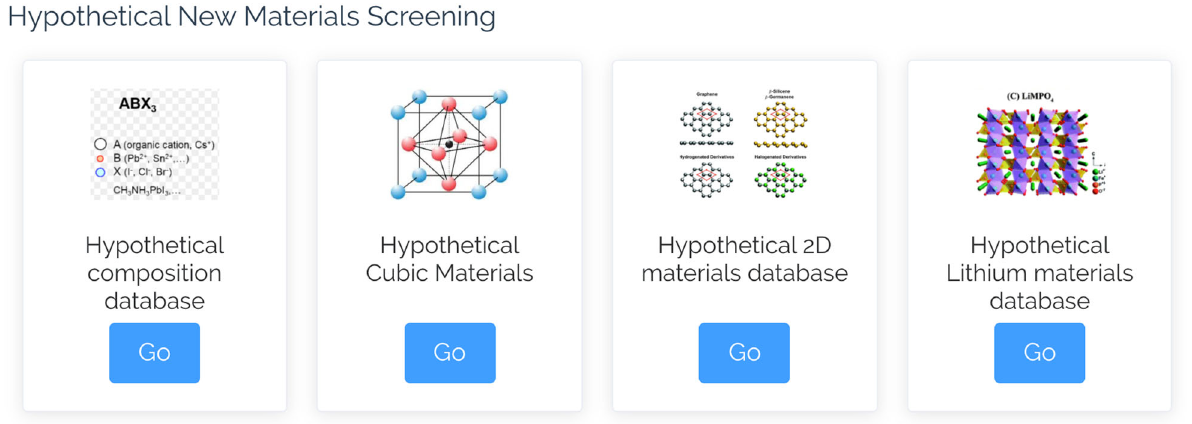
Fig. 3 Screening hypothetical materials generated by machine learning or deep learning models.